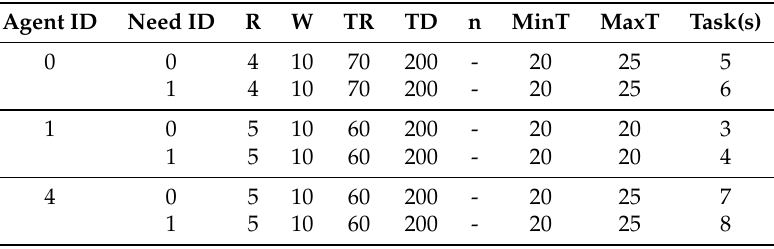
Table 7. Agents’ needs for Scenario